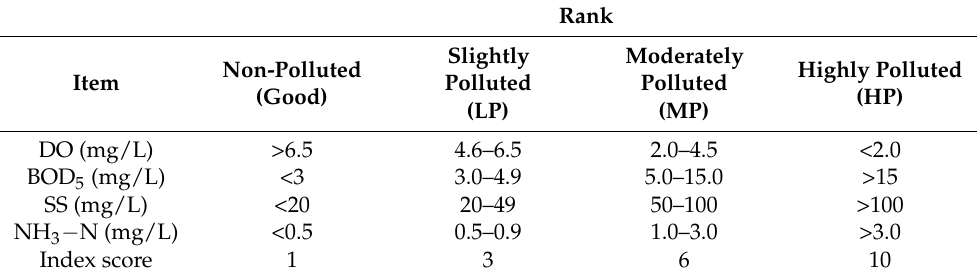
Table 3. Classification system for pollution